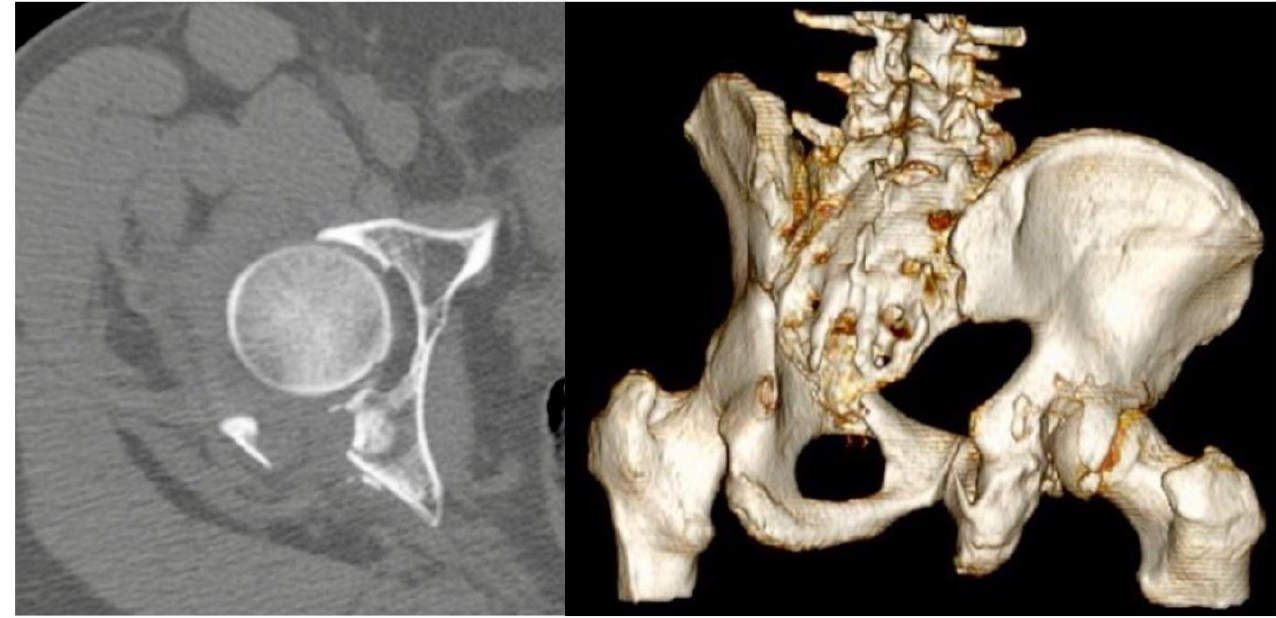
Figure 1. Computed tomography (CT) axial scans and 3D reconstruction showing comminuted posterior wall fracture with marginal impaction.